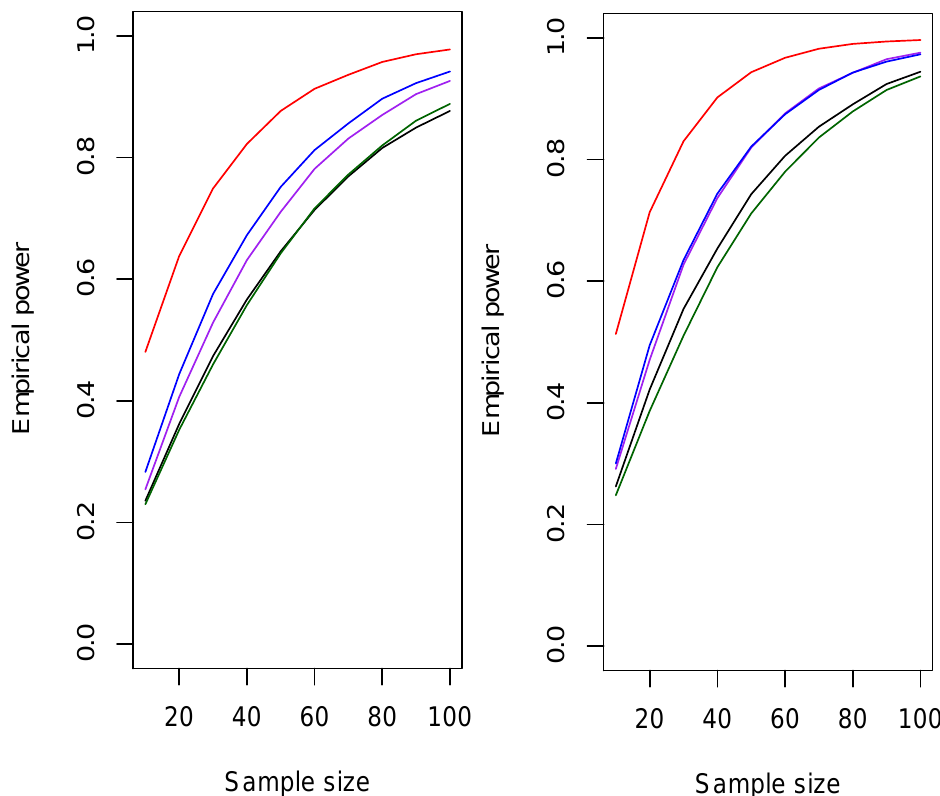
Figure 1. Empirical powers for various sample sizes against the Γ ( 2 ) ( left ) and the W ( 2 ) ( right ) alternatives. The tests considered are KS (black line), AD (purple line), HK line) and T MO (red n ,10